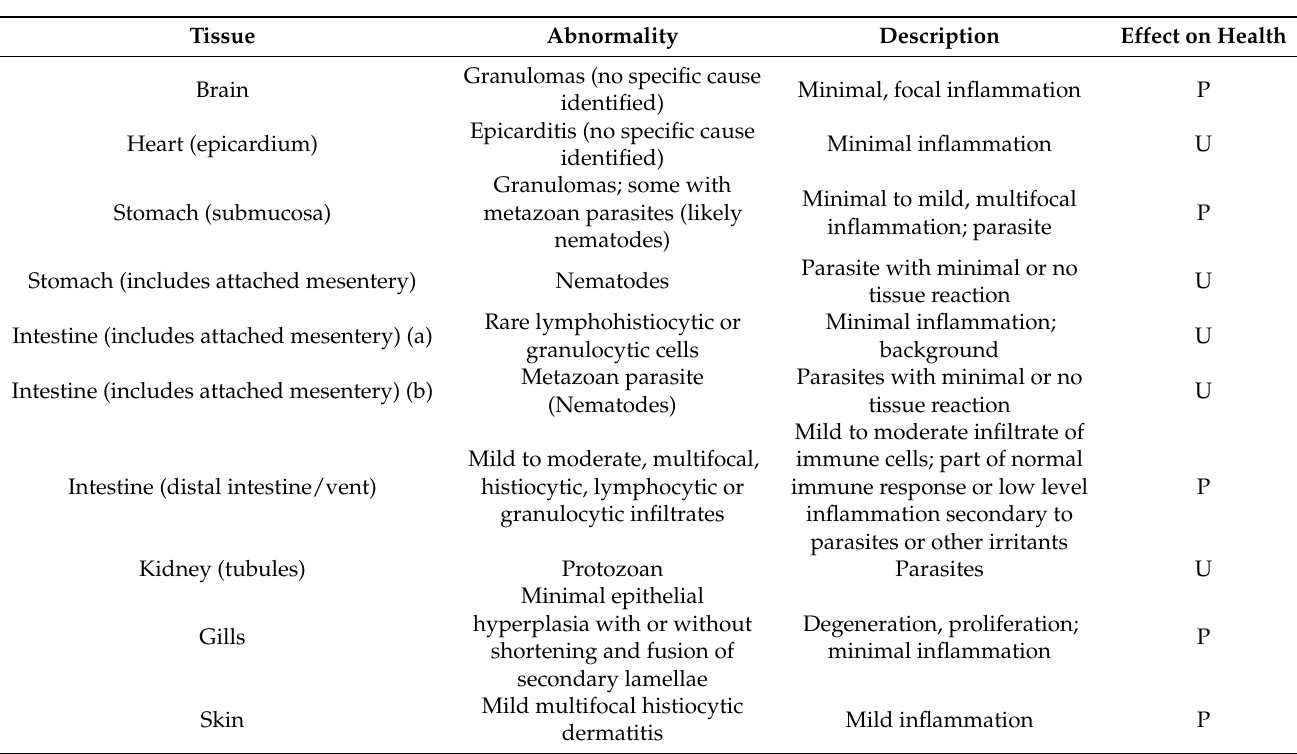
Table 1. Abnormalities in sablefish tissues identified in histology slides. Each abnormality could possibly (P) have an effect on future health or it was unlikely (U).